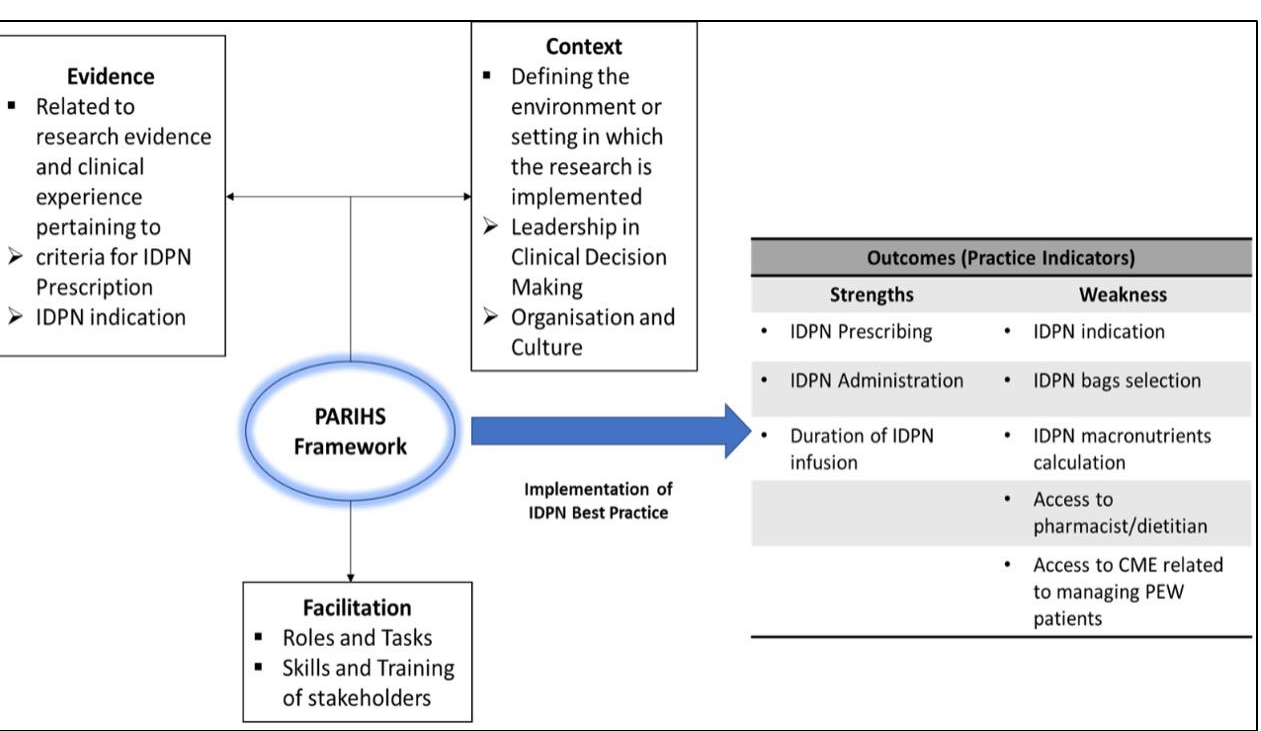
Figure 3. Outcome Summary of Implementation of IDPN Best Practice Defined by the PARIHS Frame- work.